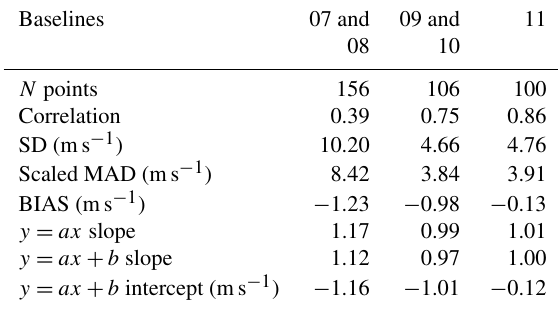
Table 7. Statistical comparison of Aeolus Rayleigh HLOS winds of different baselines and CDL-retrieved HLOS